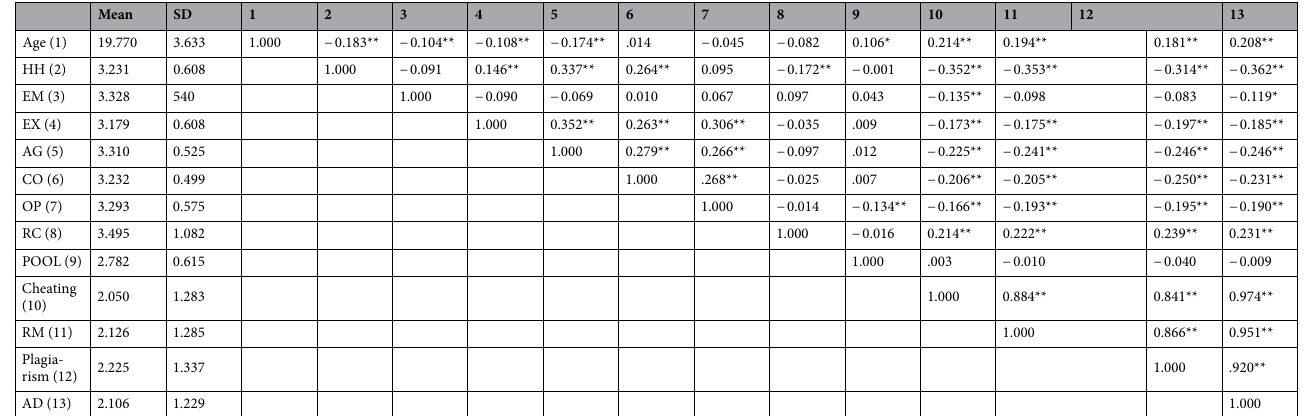
Table 1. Descriptive Statistics and Correlations among Variables. AD Academic dishonesty, RM Research misconduct, RC Rule conditionality, POOL Perceived obligation to obey the law, HH